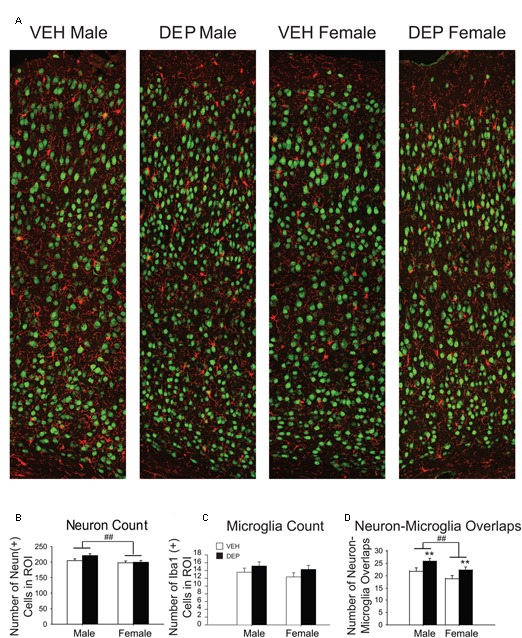
Prenatal DEP exposure alters microglia-neuron interaction frequency but not neuron or microglia number in the parietal cortex of P30 offspring. (A) Representative panoramic images of microglia (Iba1, red) and neurons (NeuN, green) in the parietal cortex of P30 offspring taken at 40× magnification and stitched together with 30% overlap. (B) Neuron Quantification. Males have significantly more NeuN+ cells than females. (C) Microglia Quantification. The numbers of Iba1+ cells do not differ by Sex, DEP exposure or the interaction of the two. (D) Microglia-Neuron Interaction Quantification. Males have significantly more overlaps between microglia and neurons than females, and DEP-treated animals have significantly more overlaps than those treated with VEH. Bar graphs represent mean values ± SEM (error bars); n = 6 mice/group, average of 3 brain sections per mouse. ##p < 0.05, males vs. females; ∗∗p < 0.05, DEP vs. VEH.